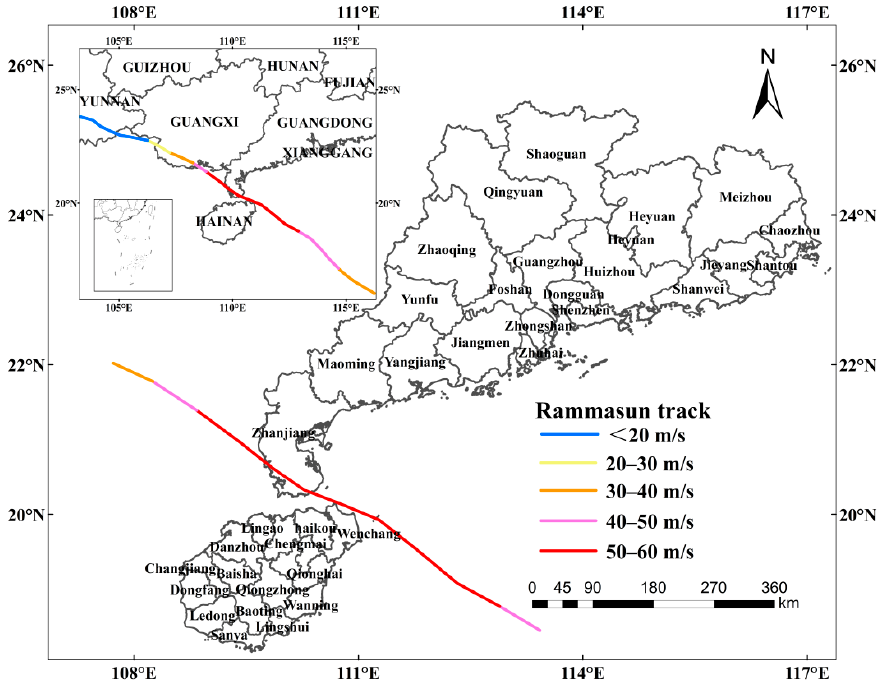
Figure 1. The administrative boundaries of cities or counties in Guangdong and Hainan Provinces and the path and wind speed of Typhoon Rammasun.